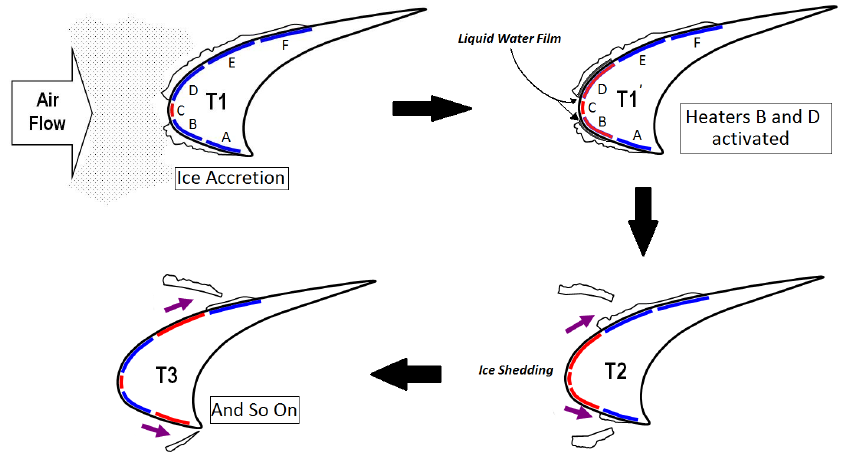
Figure 1. Operating of an ETIPS.